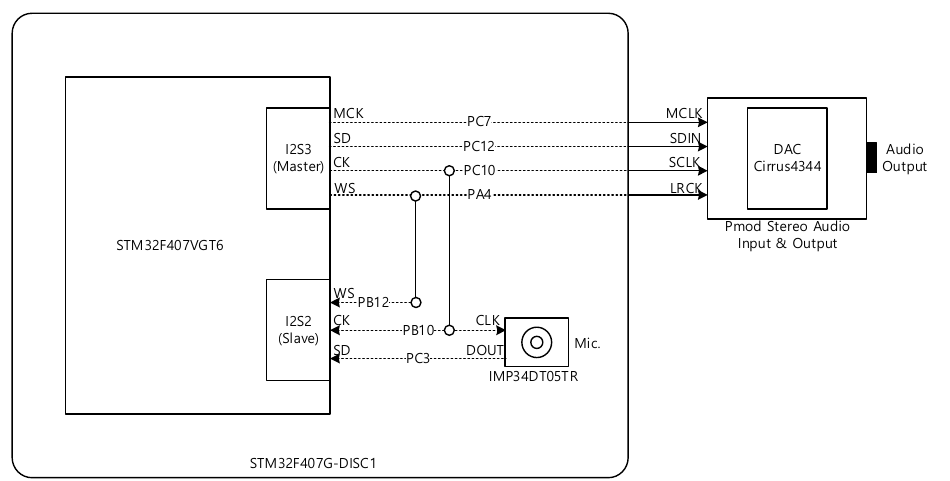
Figure 9. Hardware configuration of individual channel receiver. (SD specifies the serial data). The individual channel receivers should be combined together as the left and right channel for eyeglass receiver device. To maintain the user accessibility, the Bluetooth audio eyeglasses (Bose Frames Alto, Bose Corporation, Framingham, MA, USA) is utilized for receiver form factor and the audio eyeglasses provides the stereo sound via speakers located at the end of each temple. The channel receivers are separated from the audio eyeglasses by using the Bluetooth connection; hence, the user experiences the actual prototype without any wires on the device. Due to the separation, observe that the user motion does not correspond with the receiver device movement. Figure 10 represents the overall system connections for the eyeglass receiver device. The analog mixer (Xenyx 802, Behringer, Willich, Germany) merges the left and right channel receiver for stereo output. The Bluetooth transmitter (ABC01F, Aluratek, Irvine, CA, USA) sends the stereo audio signal to the audio eyeglasses by using the wireless connection.